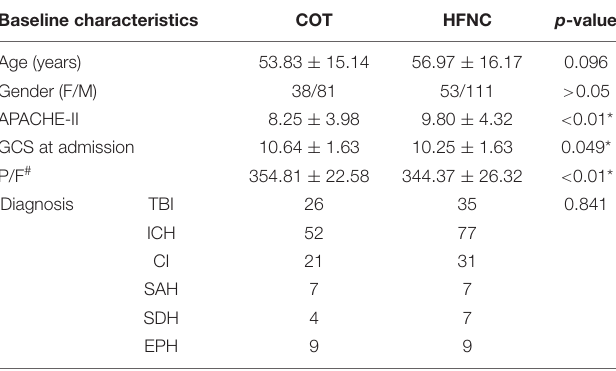
TABLE 1 | Comparison of clinical characters between COT group and HFNC group. Baseline characteristics